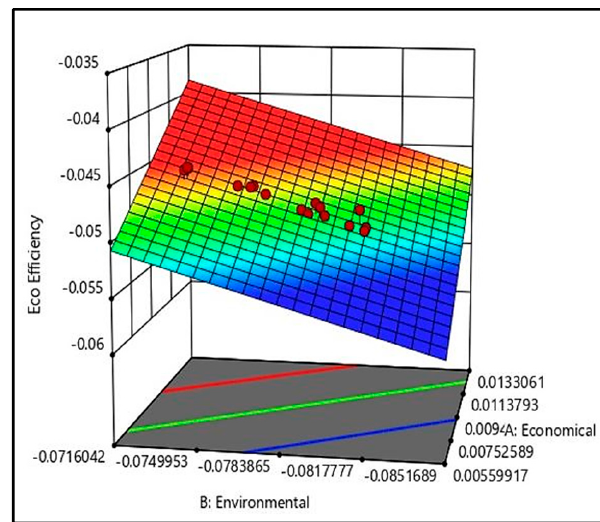
Figure 15. Response surface graph of fly ash based concrete used for single story houses.